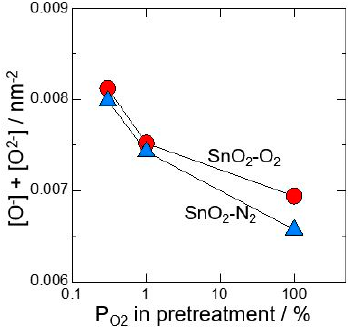
Figure 2. Total amounts of [O 2 − ] and [O − ] against oxygen partial pressure in pretreatment (measured in dry atmosphere).